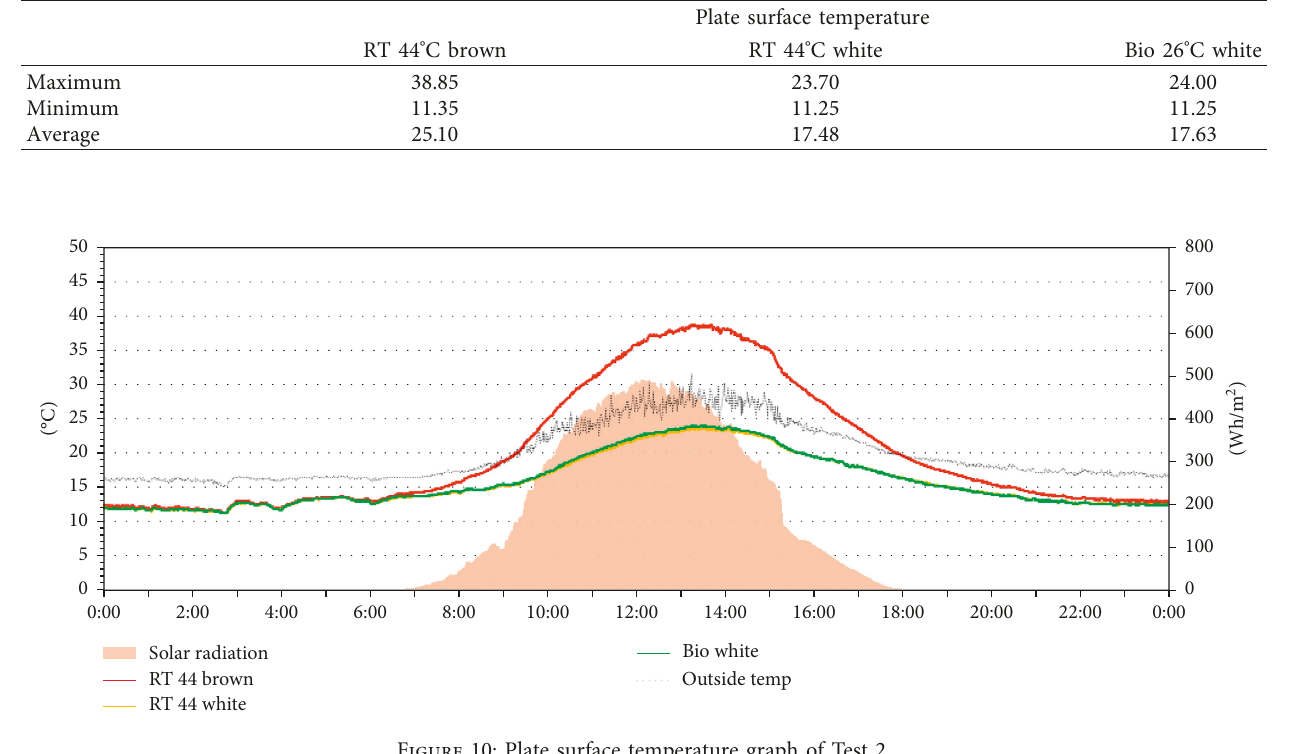
Figure 10: Plate surface temperature graph of Test 2.